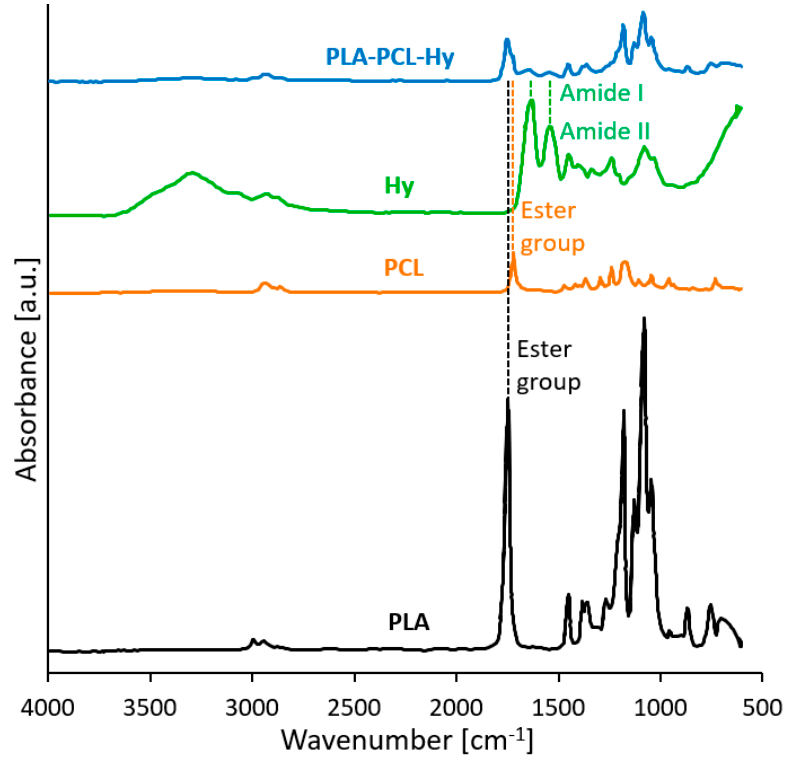
Figure 1. FTIR spectra of the neat starting materials (PLA, PCL), of the hydrogel constituting the shell (Hy) and of the assembled core-shell system (PLA-PCL-Hy).